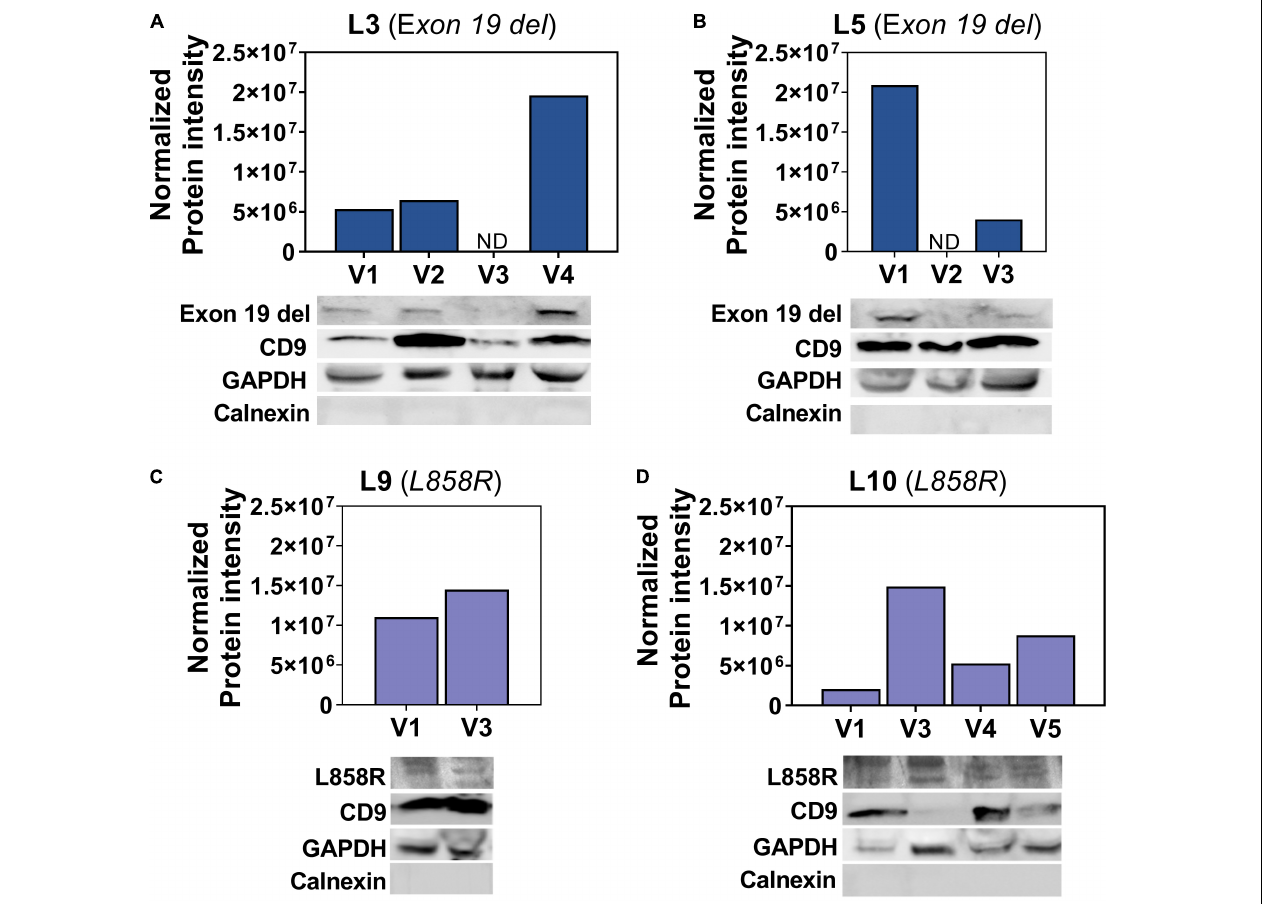
FIGURE 2 | Detection of EGFR mutations in EV-protein. (A–D) EV-protein with detected mutant EGFR from patients across multiple visits from (A) L3 with exon 19 del, (B) L5 with exon 19 del, (C) L9 with L858R, and (D) L10 with L858R. Samples were additionally screened for CD9, GAPDH, and calnexin. Normalized mutant EV-protein is quantified above each western blot using Bio-Rad’s Stain Free Gel technology to normalize to the total protein as quantified by imaging the Stain Free Gel after transfer to a PVDF membrane. ND, not